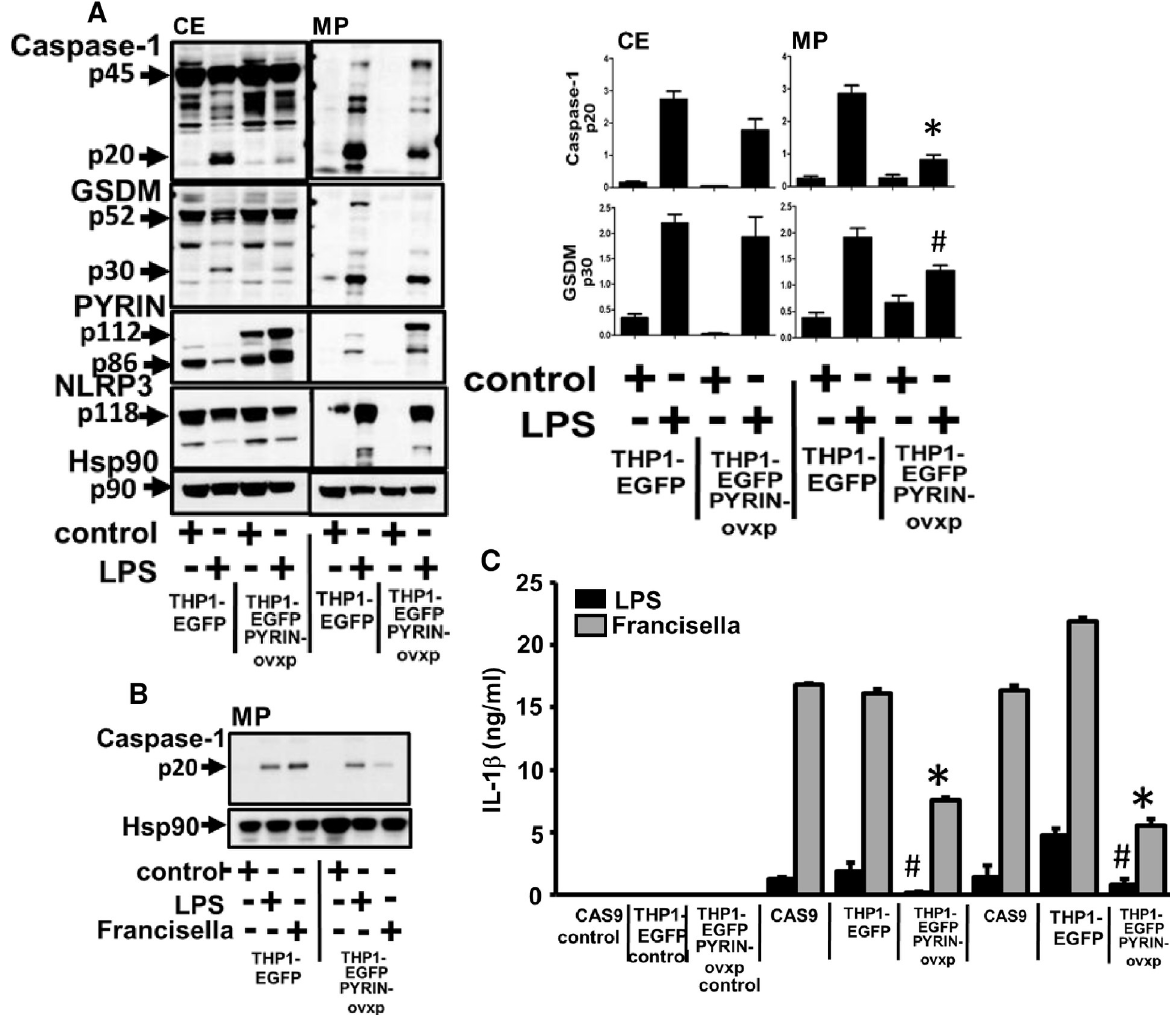
Fig 3. Microparticulate active caspase-1 and GSDM-D release by LPS and Francisella is negatively regulated by Pyrin overexpression. A) Cell lysates (CE) and microparticles (MP) fractions were isolated from THP-1 EGFP, THP1-EGFP overexpressed Pyrin cells stimulated with LPS (1 μ g/ ml) for 2h or left untreated and analyzed for the presence of active p20 caspase-1 and p30 GSDM-D. Pyrin-EGFP overexpression was confirmed at 112kD which was not detected in the vector control cells. Endogenous pyrin at 86kD was detected in both cell types. Overexpressing Pyrin significantly inhibited caspase-1 activation (p20) and GSDM-D cleavage (p30) in microparticles. Densitometry scans of active caspase-1 levels from n = 4 experiments. � p20 active caspase-1 levels in MP THP1-EGFP vs THP1-EGFP Pyrin. # p30 active GSDM-D levels in MP THP1-EGFP vs THP1-EGFP Pyrin. B) Similar experiments were performed also with overnight (17h) stimulation with LPS and Francisella . THP-1 EGFP, THP1-EGFP overexpressed Pyrin cells were stimulated with LPS (1 μ g/ml), Francisella (25MOI) for 17h or left untreated and analyzed for the presence of active p20 caspase-1 and p30 GSDM-D. C) CAS9, THP-1 EGFP, THP1-EGFP overexpressed Pyrin were stimulated with LPS (1 μ g/ml) or Francisella for 4h, overnight (17h) or left alone. IL-1 β was measured from supernatants. Release of IL-1 β was significantly diminished with overexpression of Pyrin. Data is representative of n = 4 experiments.THP1-EGFP vs THP1-EGFP Pyrin � IL-1 β levels at 4 and 17h upon Francisella stimulation; # IL-1 β by LPS stimulation for 4 and 17h.